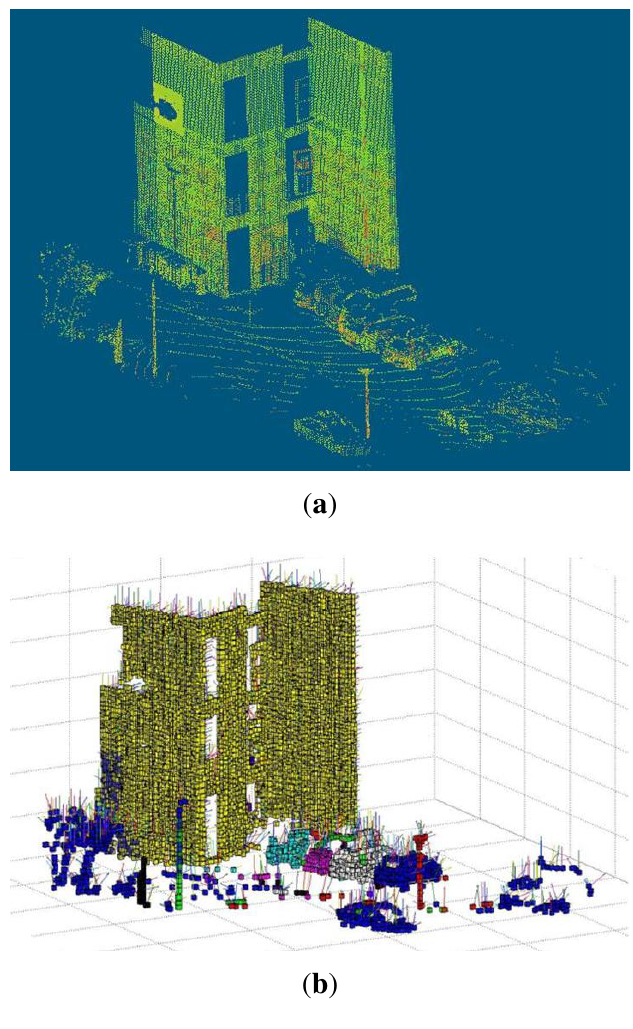
Figure 7. (a) 3D data points—shows 3D data points of data set 3. (b) Voxelisation and segmentation into objects—shows s -voxel segmentation of 3D points (along with orientation of normals). (c) Labeled points—shows classification results (labeled 3D